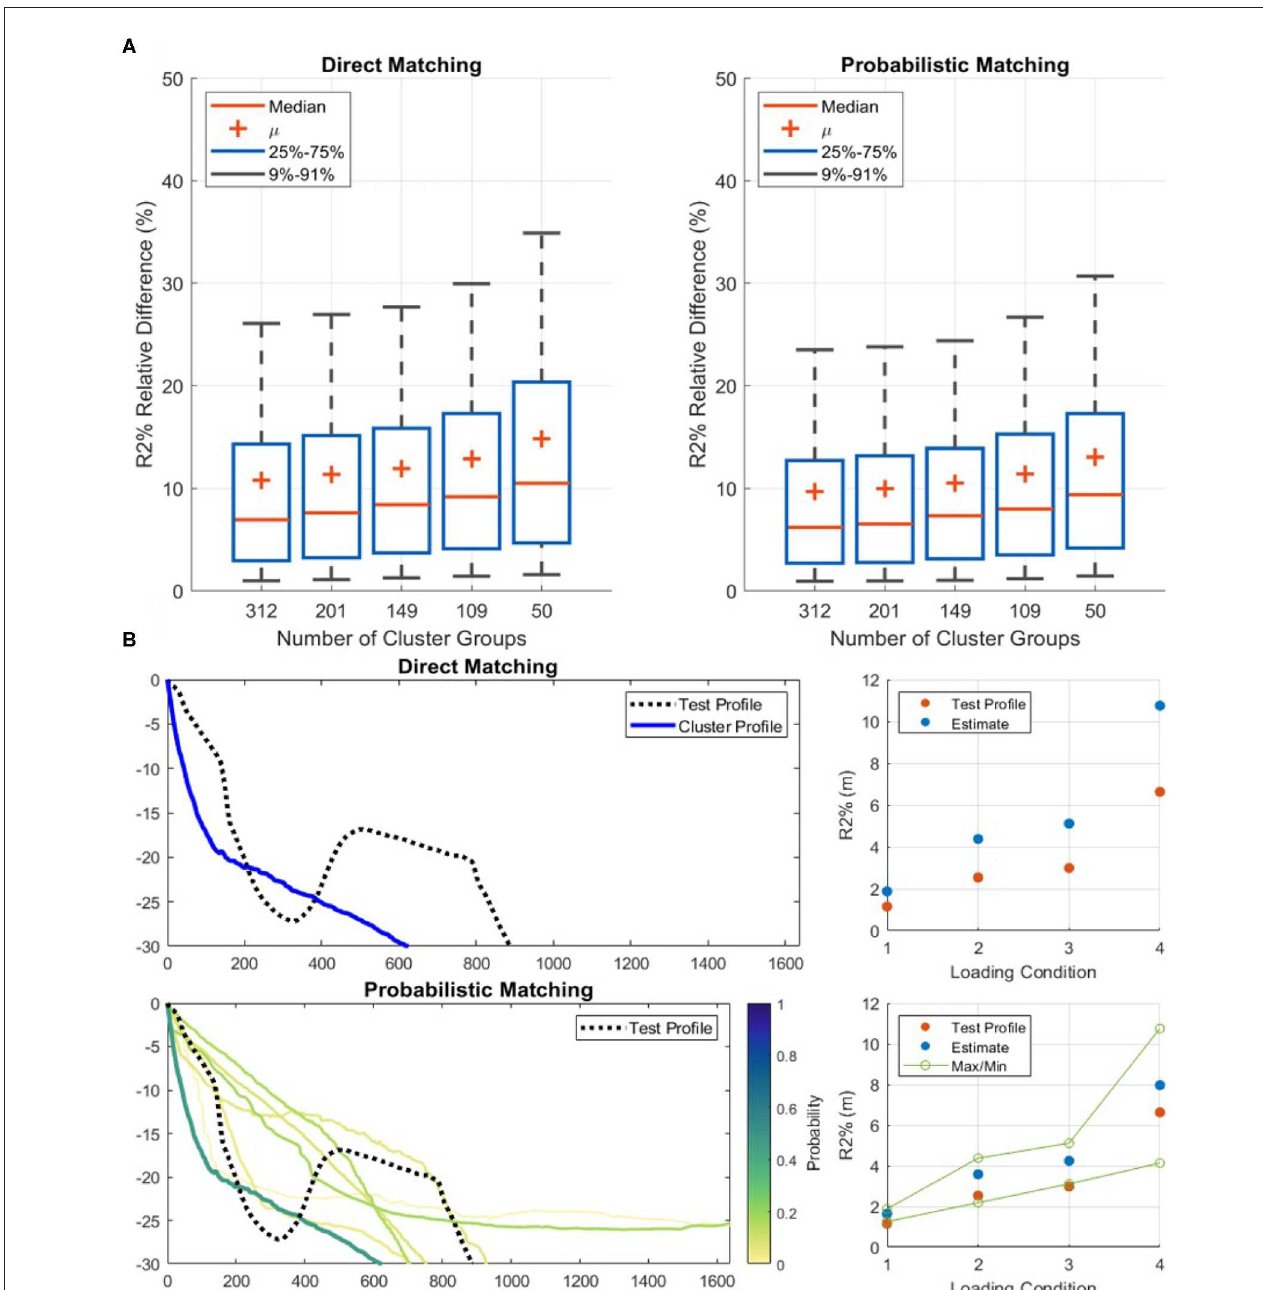
FIGURE 10 | Results of the direct and probabilistic matching method. (A) The probabilistic technique has a slightly greater accuracy in R 2 % estimation. For both cases, the accuracy decreases as the number of representative cluster profiles (RCPs) decrease. (B) An example of the two matching techniques when using 50 RCPs with one of the unique test profiles. The scatter plots provide the modeled value and estimate of R 2 % for the four loading conditions ( Table 2 ). The test profile does not match well to any of the RCPs, and therefore the R 2 % estimation from the direct matching technique suffers. The estimation from the probabilistic technique is influenced from multiple RCPs and is more accurate for all four loading conditions. The green values in the scatter plot represent the confidence bands that can be determined while using the probabilistic